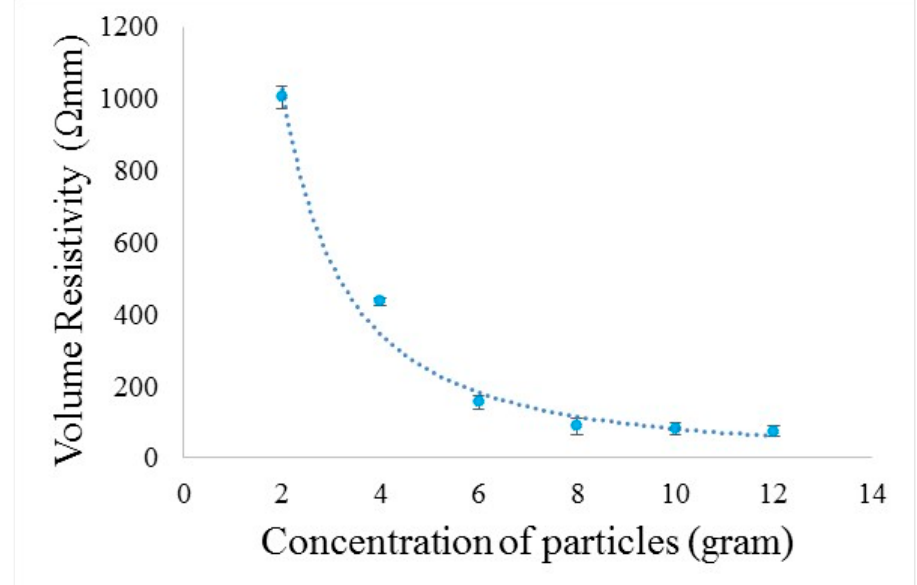
Figure 11. Electrical resistivity of conductive paste.